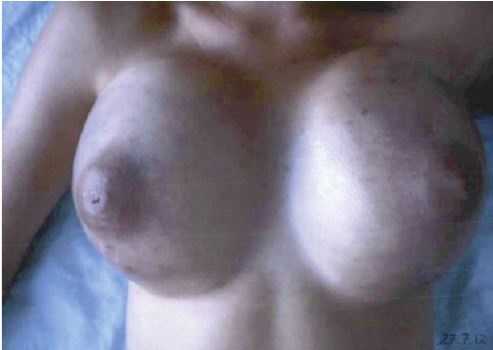
Figure 1: Initial clinical presentation, massive enlarged bilateral breast masses.